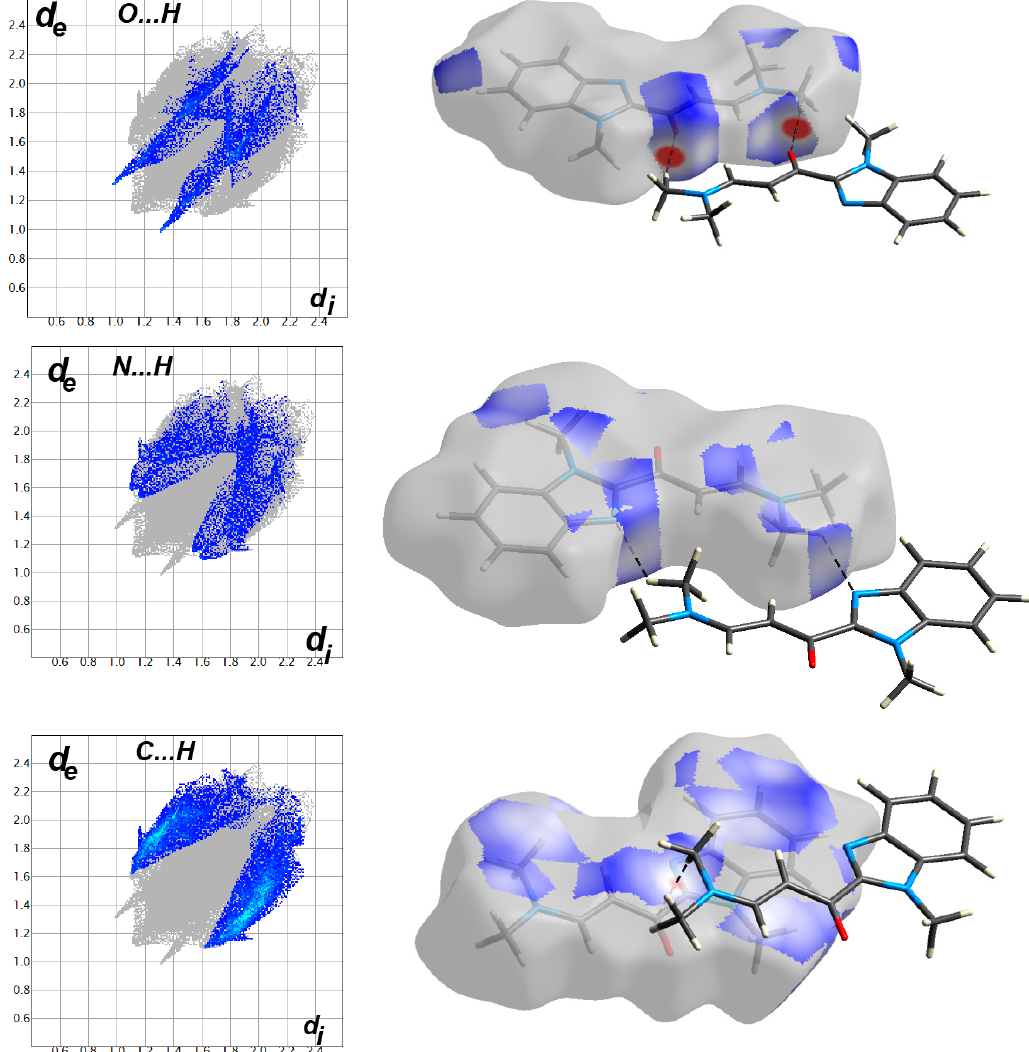
Figure 4. The O…H, C…H and N…H interactions in 2 observed using Hirshfeld analysis. On the other hand, compound 3 crystal packing depends on a large contribution of H...H